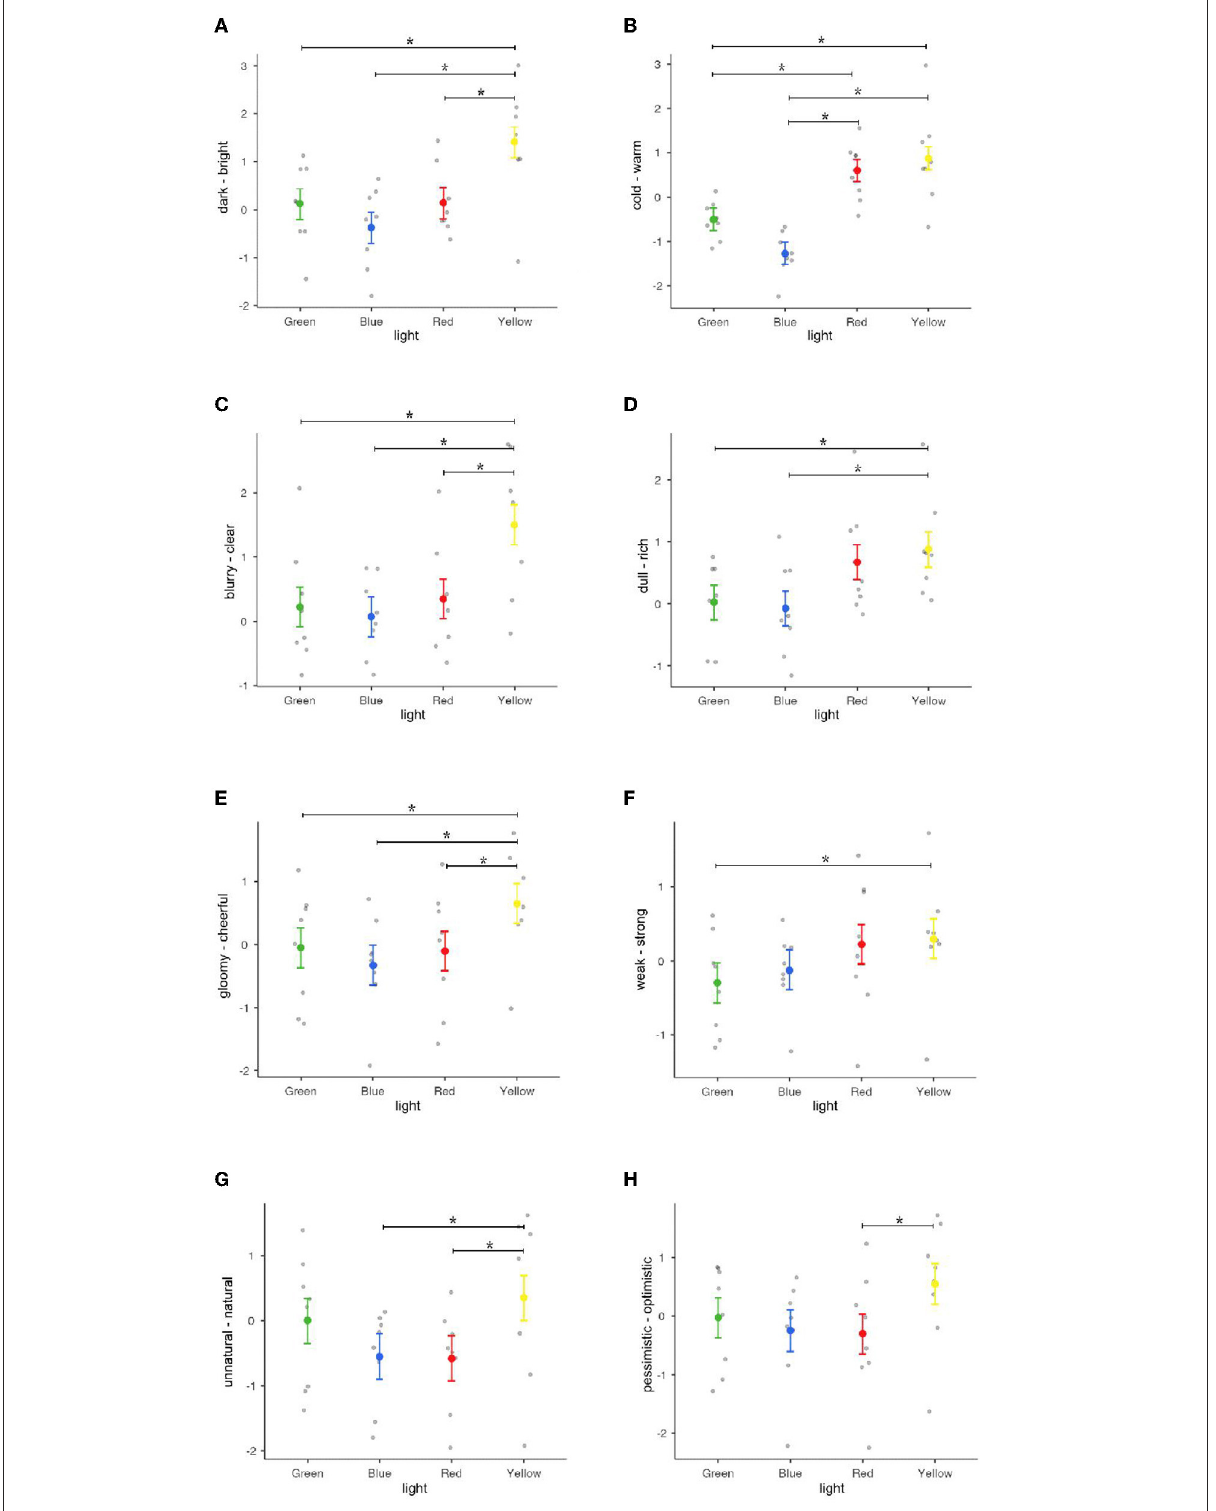
FIGURE7 Result of participants’ impressions in experiment 1: (A) Dark-bright impression, (B) cold-warm impression, (C) blurry-clear impression, (D) dull-rich impression, (E) gloomy-cheerful impression, (F) weak-strong impression, (G) unnatural-natural impression, and (H) pessimistic-optimistic impression. * p <